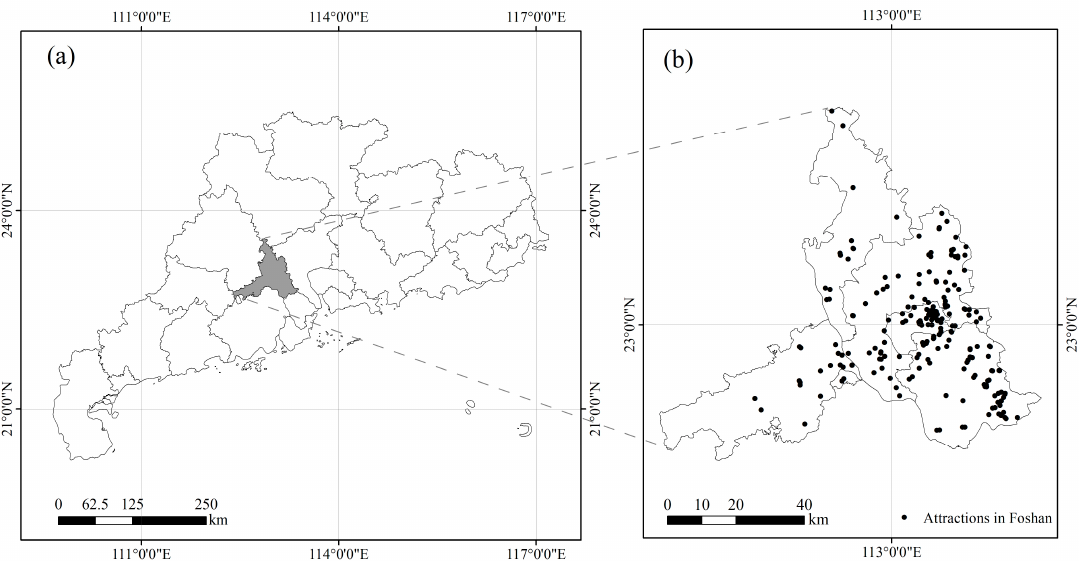
Figure 1. Geographical location of Foshan: ( a ) the location of Foshan City in Guangdong Province; ( b ) distribution map of major scenic spots in